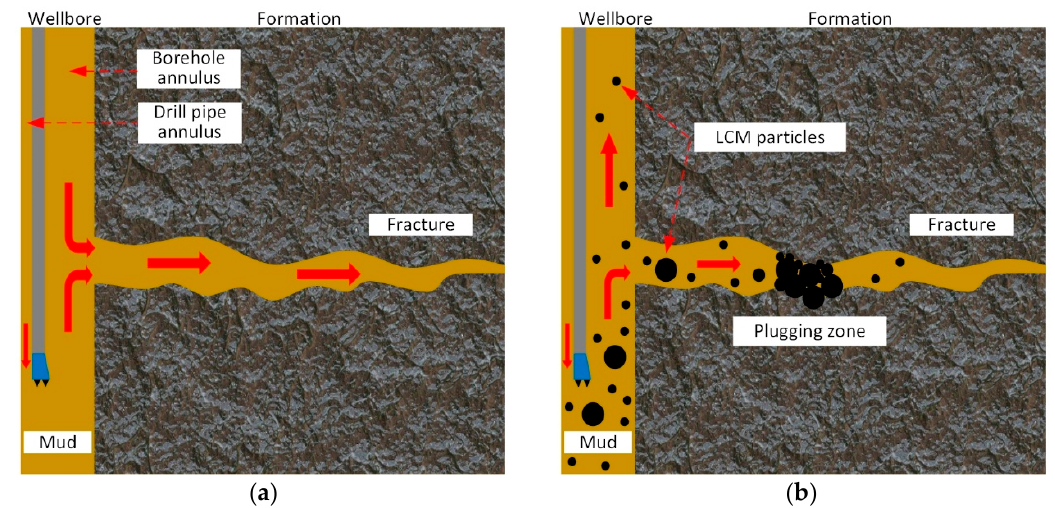
Figure 1. The schemes of ( a ) drilling fluid loss and ( b ) lost circulation control while drilling.